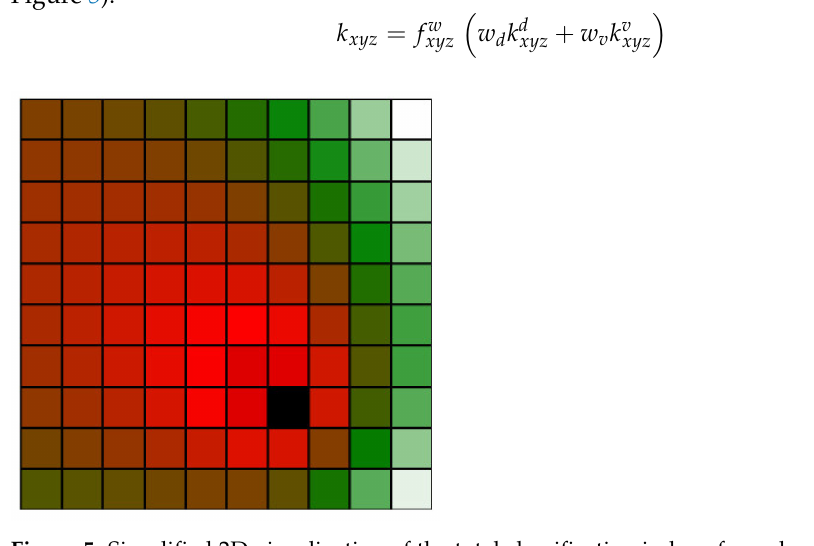
Figure 5. Simplified 2D visualization of the total classification index of voxels around an obstacle (the black